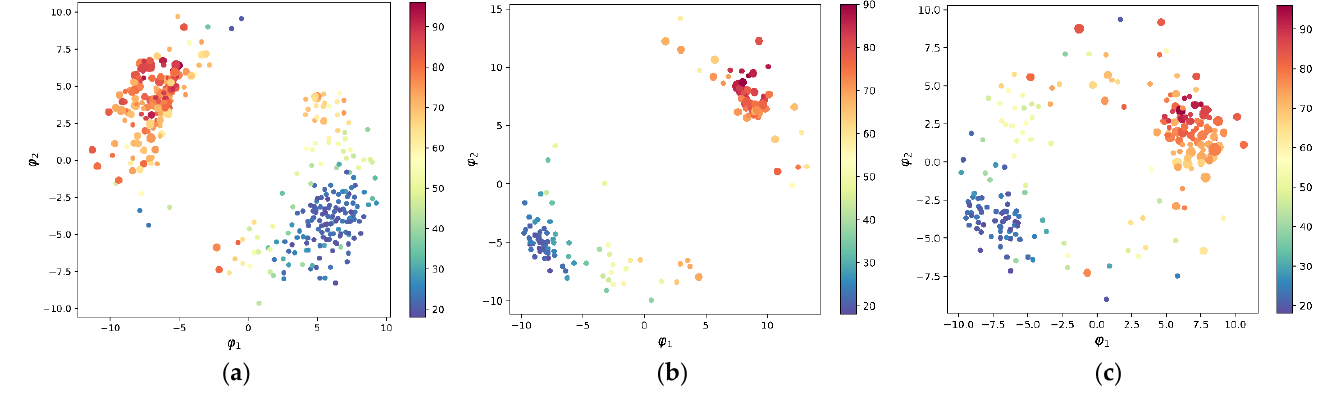
Figure 8. Two-Dimensional visualization of SHAP values for individuals of different ages. The color bar indicates the age, and the size of the dots from small to large indicates the subject’s four levels of dementia, which are no dementia, very mild dementia, mild dementia, and moderate dementia. ( a ) Visualization for all subjects, ( b ) visualization for males, and ( c )visualization for females.